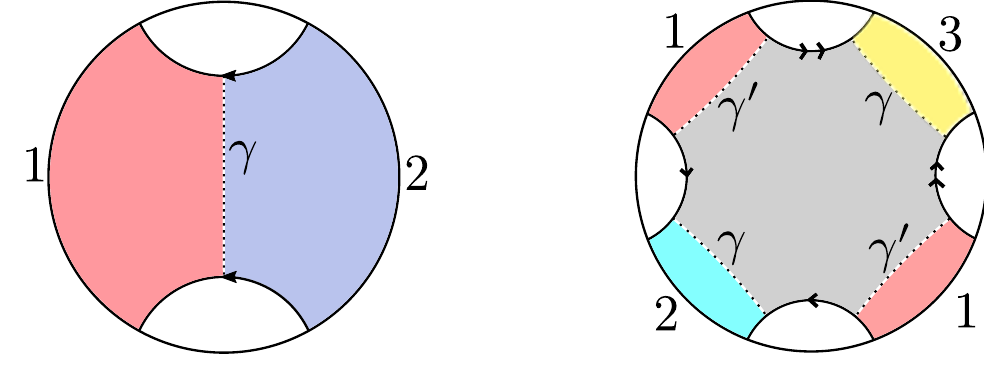
Figure 1 . Constructing wormhole spatial geometries by quotients of the Poincar(cid:19)e disk. On the left we remove two semicircles to and identify to produce a Cauchy slice of the BTZ wormhole, with the bifurcate horizon being the dotted line marked (cid:13) . The topology is that of a cylinder. On the right we remove four semicircles to construct a Cauchy slice of a three-exit wormhole with the topology of a pair of pants. The exits are labeled 1 ; 2 ; 3, the shared interior is shaded grey, and a pair of extremal surfaces (cid:13) and (cid:13) 0 which are both homologous to exit 1 are marked with dotted lines. In our unitary model below, (cid:13) 0 will be the HRT surface at late times and (cid:13) will be the HRT surface at early